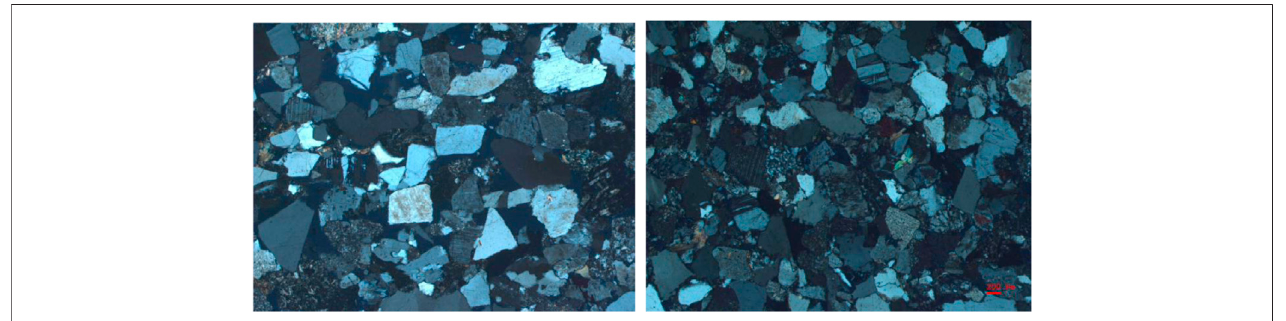
FIGURE 1 | Analysis of Shaximiao Formation rock slice in Jinqiu gas fi